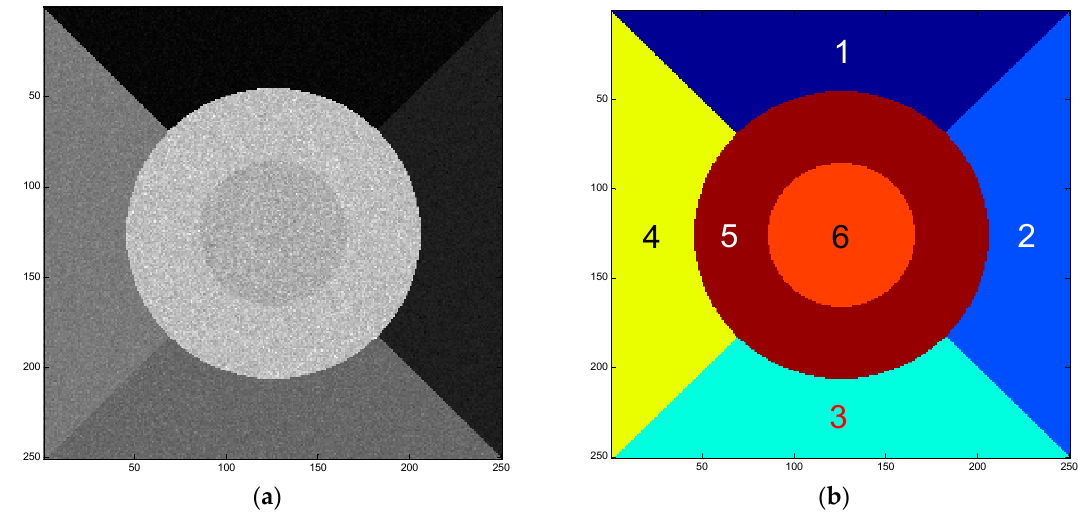
Figure 3. ( a ) Simulated synthetic aperture radar (SAR) image with six regions following the generalized gamma distributions (G Г Ds) and ( b ) the corresponding ground truth.